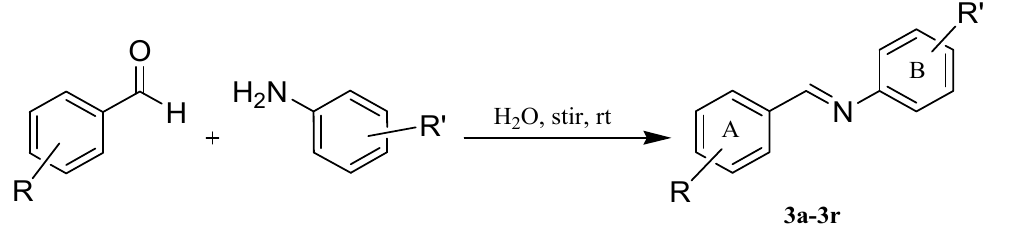
Figure 2. Synthesis of resveratrol derivatives.